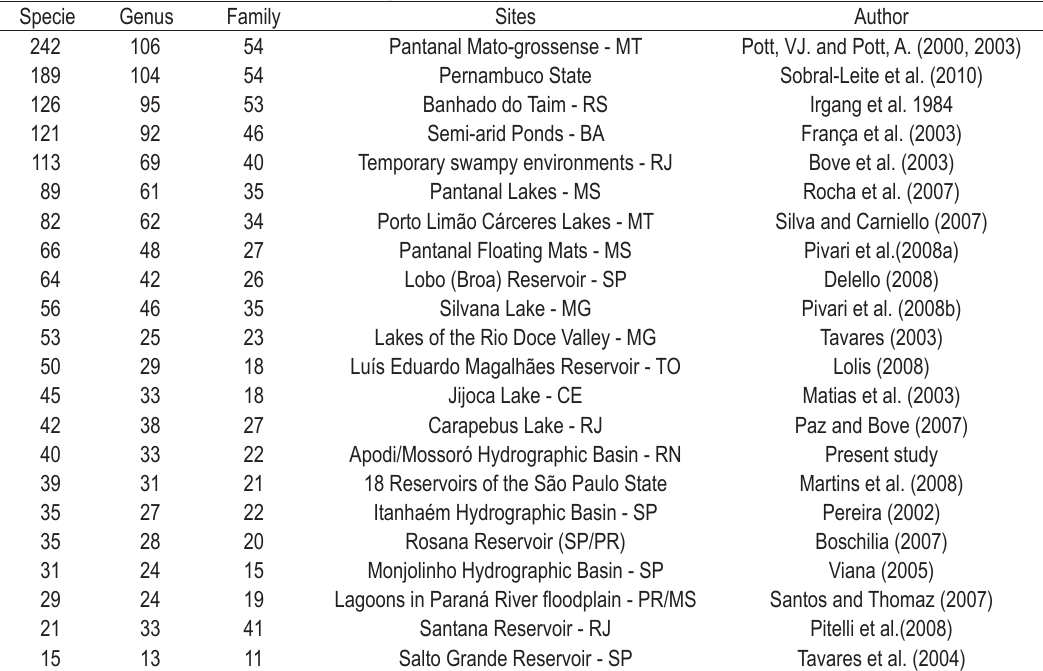
Table 3. Comparison of the aquatic macrophytes registered in hydrographic basin of the Apodi/Mossoró River, RN, Northeast Brazil, and in others Brazilian aquatic